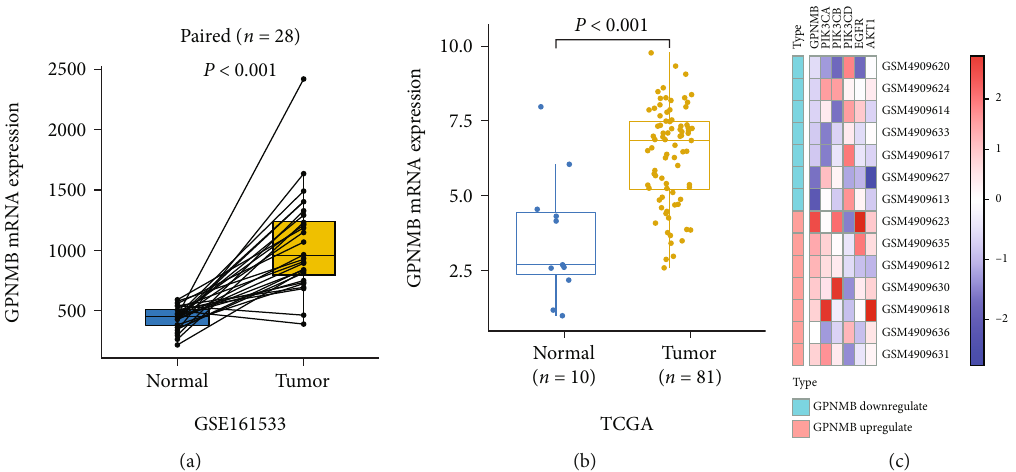
Figure 1: GPNMB mRNA expression was increased in ESCC and correlated with the PI3K pathway. (a) The GPNMB expression di ff erence between 28 pairs of ESCC and paired paracancer tissues in the GEO database was analyzed by paired T -test. Results are presented as means ± SD ; the box plot shows the median value (quartile) of the two groups. (b) Di ff erences in GPNMB expression between ESCC ( n = 81 ) and normal esophageal tissues ( n = 10 ) in TCGA were analyzed by Wilcoxon rank-sum test. The results were counted as the median di ff erence; the box plot shows the median value (quartile) of the two groups. (c) In the GEO (GSE161533) database, ESCC samples with the highest ( n = 7 ) and lowest ( n = 7 ) GPNMB expression were selected for di ff erential gene analysis. Heat maps of PI3K pathway-related gene expression in GPNMB upregulated and downregulated samples. Red indicates upregulated genes and blue indicates downregulated genes.